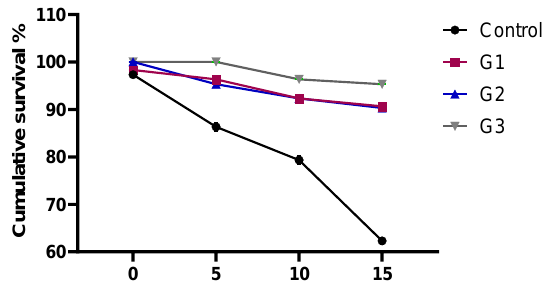
Figure 4. Effect of diets fortified with Thy and/or ThQ on cumulative survival percentage of Nile tilapia challenged with Aeromonas sorbia . Control: tilapia fed basal diets without any supplementa- tions, G1: tilapia fed basal diets with thymol (Thy) supplementation at a concentration of 200 mg/kg diet, G2: tilapia fed basal diets with thymoquinone (ThQ) supplementation at a concentration of 200 mg/kg, diet and G3: tilapia fed basal diets with Thy/ThQ supplementation at a concentration of 200 mg/kg diet each.